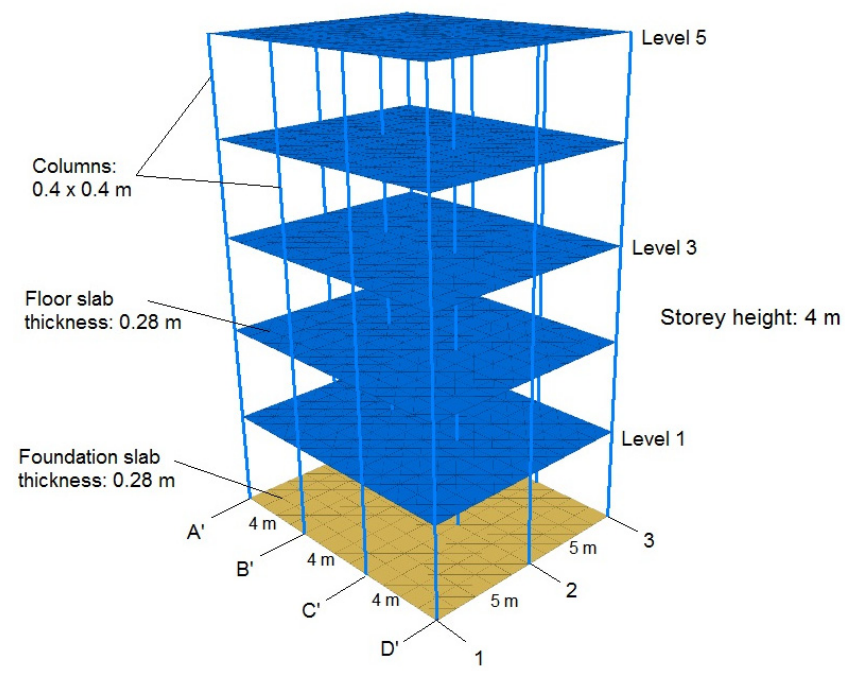
Figure 2. Direct and substructure methods in the soil–pile–structure interaction.